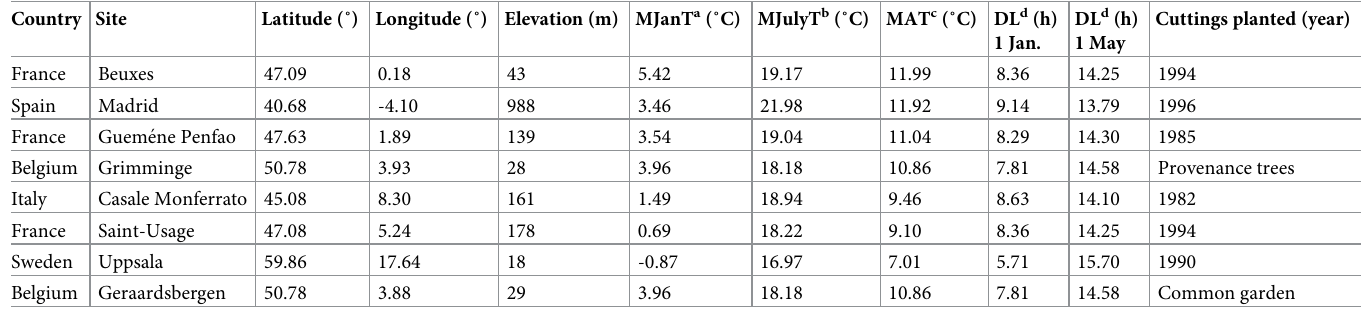
Table 1. Background information of the study sites across Europe where poplar trees were transplanted and sampled. Country